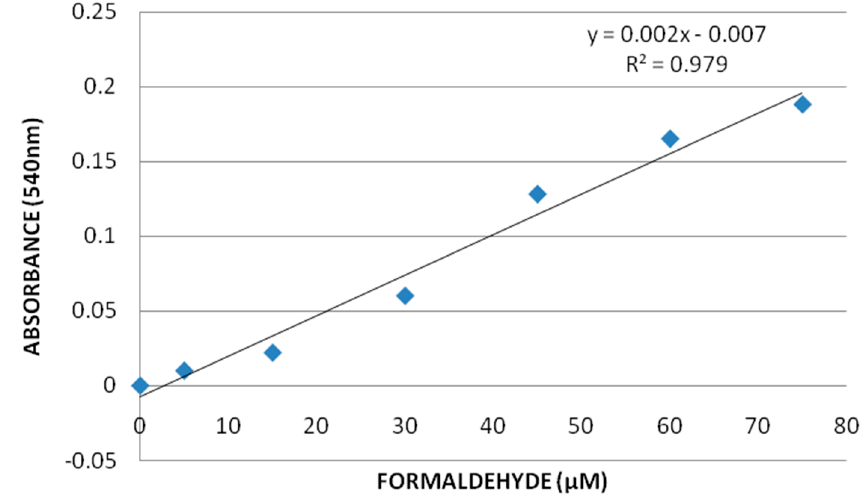
Figure 3. Catalase (CAT) assay standard curve where y-axis represents the net absorbance at 540 nm and x-axis represents the various concentrations of reference standards, formaldehyde ( µ M).